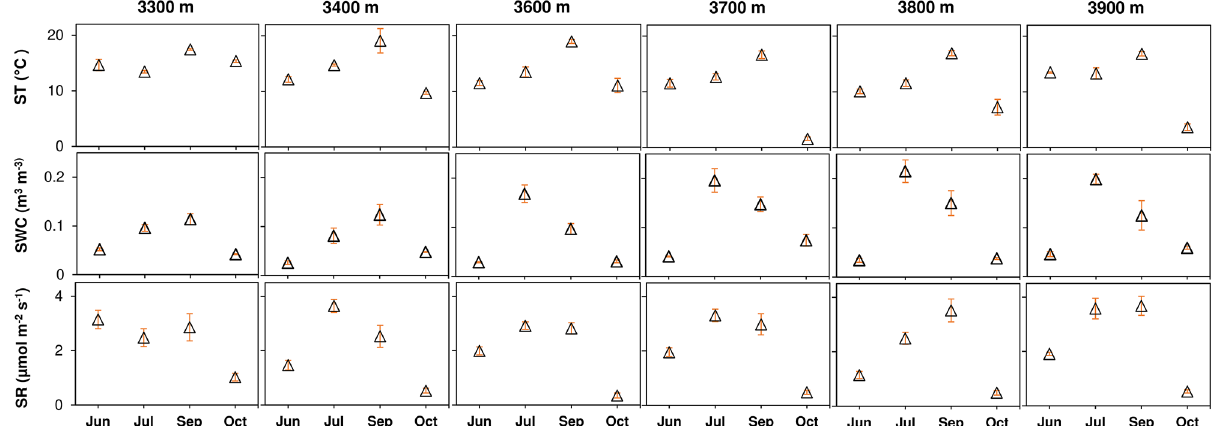
Figure 1. Soil temperature, moisture and, respiration at different elevations. Each triangle represents the mean environmental parameter (ST: soil temperature at 5 cm depth, SWC: volumetric soil water content at 5 cm depth, and SR: soil respiration; n = 12) ± standard error of mean during four months in